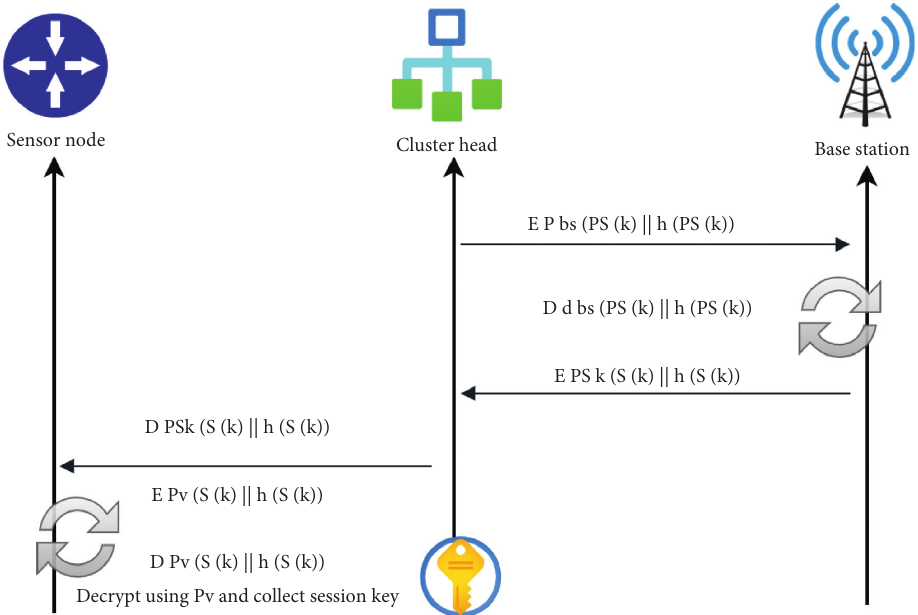
Figure 1: Scenario of the proposed